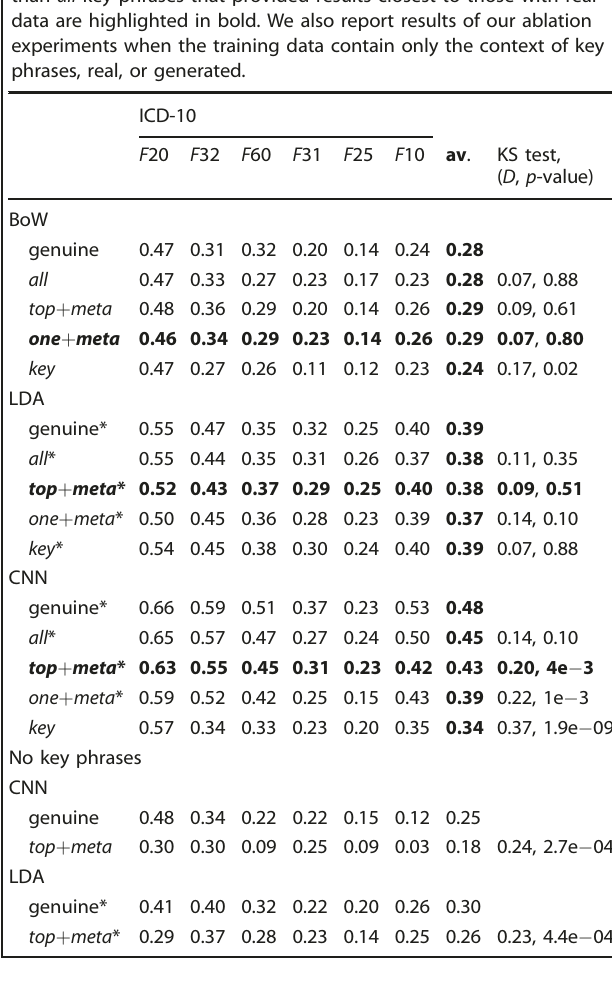
to verify if the real key phrases in the arti fi cial data in fl uence the classi fi ers. Again for the top + meta setup, we remove the common key phrases from both the genuine and arti fi cial data, and compare the performance of our classi fi ers. We focus on the best- performing LDA and CNN. Table 7, last four lines, shows the results of those experiments. We again observe comparable perfor- mances for the genuine and arti fi cial models. This con fi rms that our arti fi cial data captures relevant information.